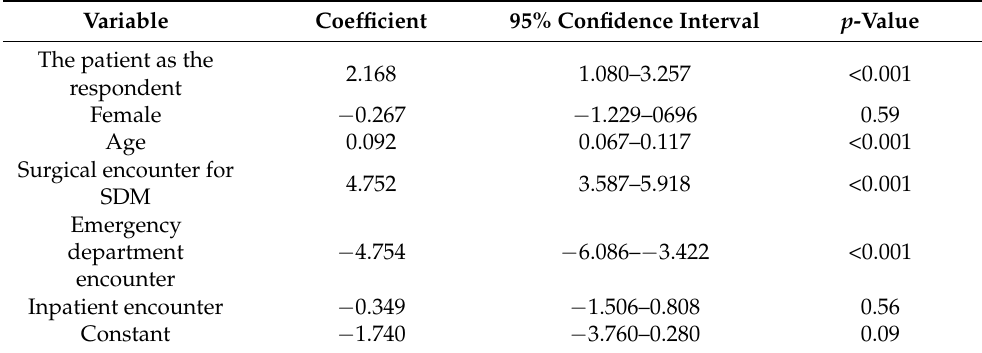
Table 4. Multivariate linear regression analysis of the interval between triggering SDM and response (days) ( n = 3482).